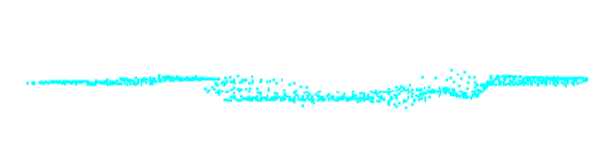
Figure 9: Side view of point cloud after sampling on surfaces